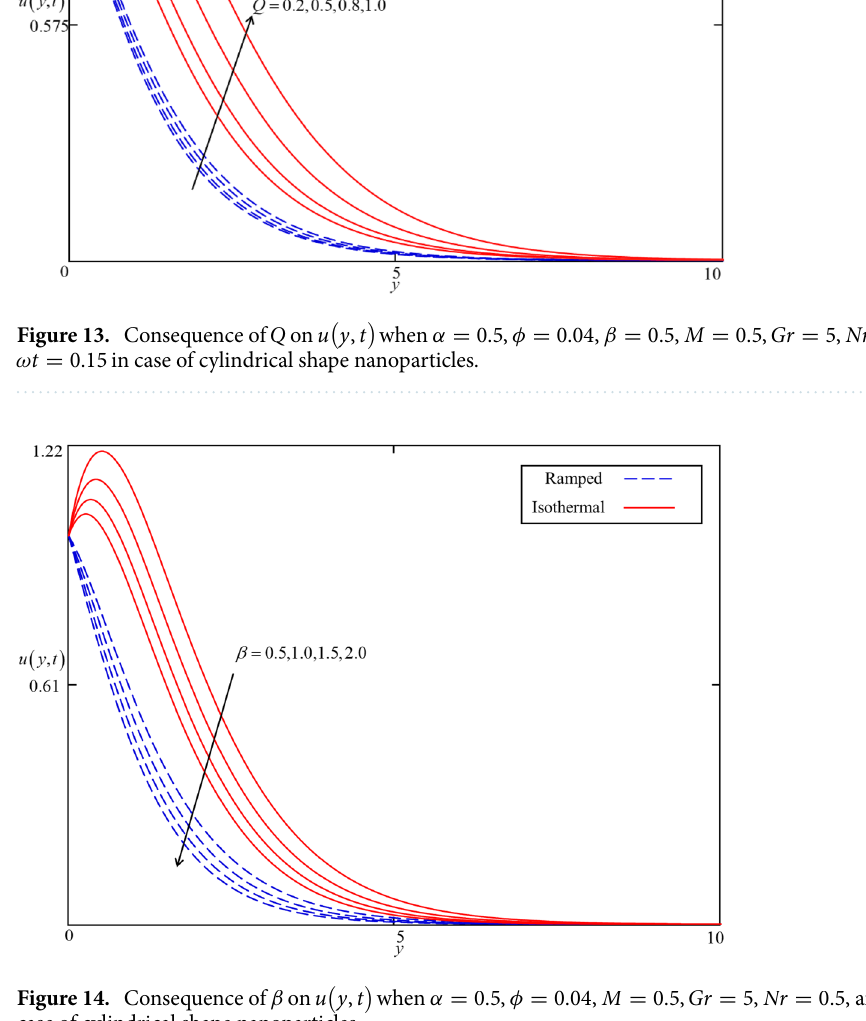
Figure 14. Consequence of β on u case of cylindrical shape